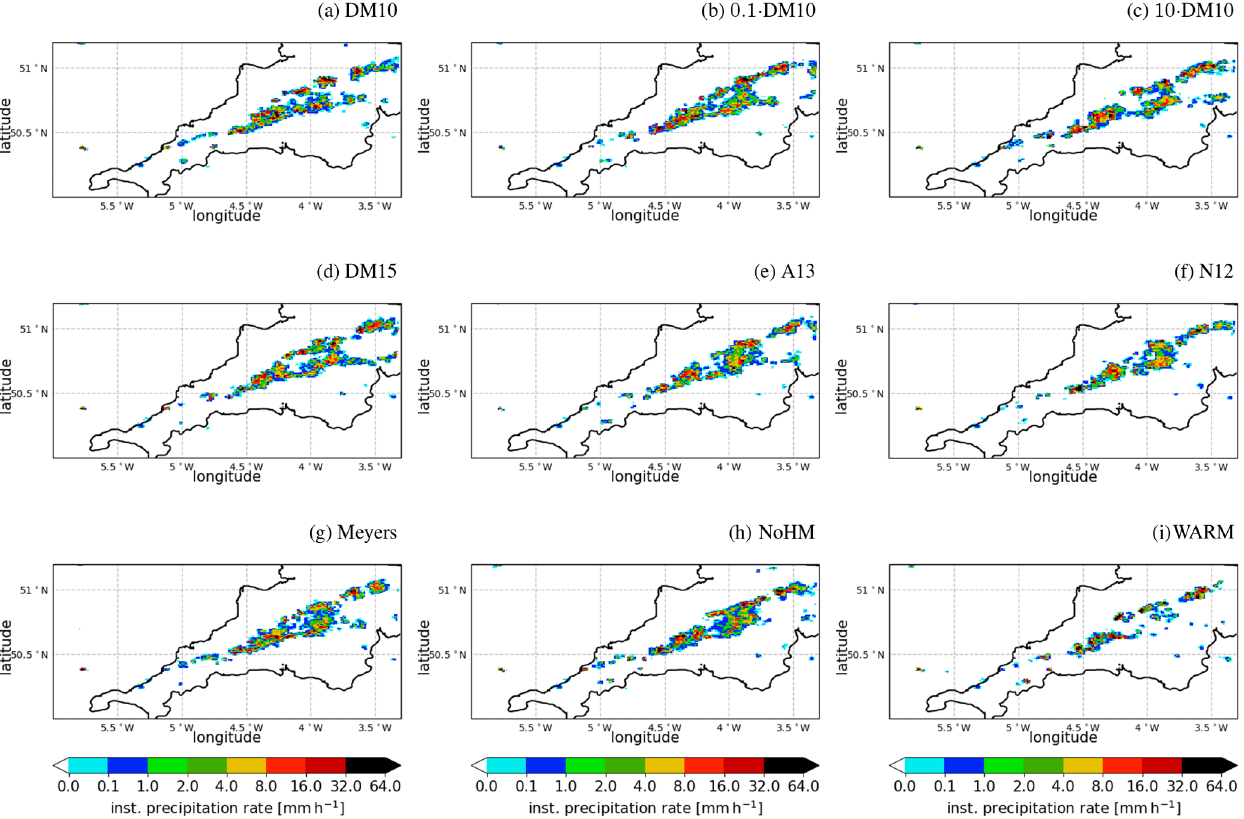
Figure 3. Instantaneous precipitation rate at 14:00UTC in the different model simulations. Panels (a) – (c) show simulations using the DeMott et al. (2010) parameterization, multiplied by factors 1, 0.1, and 10 respectively. The simulation in panel (a) corresponds to the “baseline” sim- ulation. Panels (d) – (g) show simulations using the parameterizations by DeMott et al. (2015), Atkinson et al. (2013), Niemand et al. (2012), and Meyers et al. (1992). Panel (h) shows the simulation with the DeMott et al. (2010) parameterization but without a parameterization of the Hallett–Mossop processes. Panel (i) shows the simulation without any representation of ice formation.